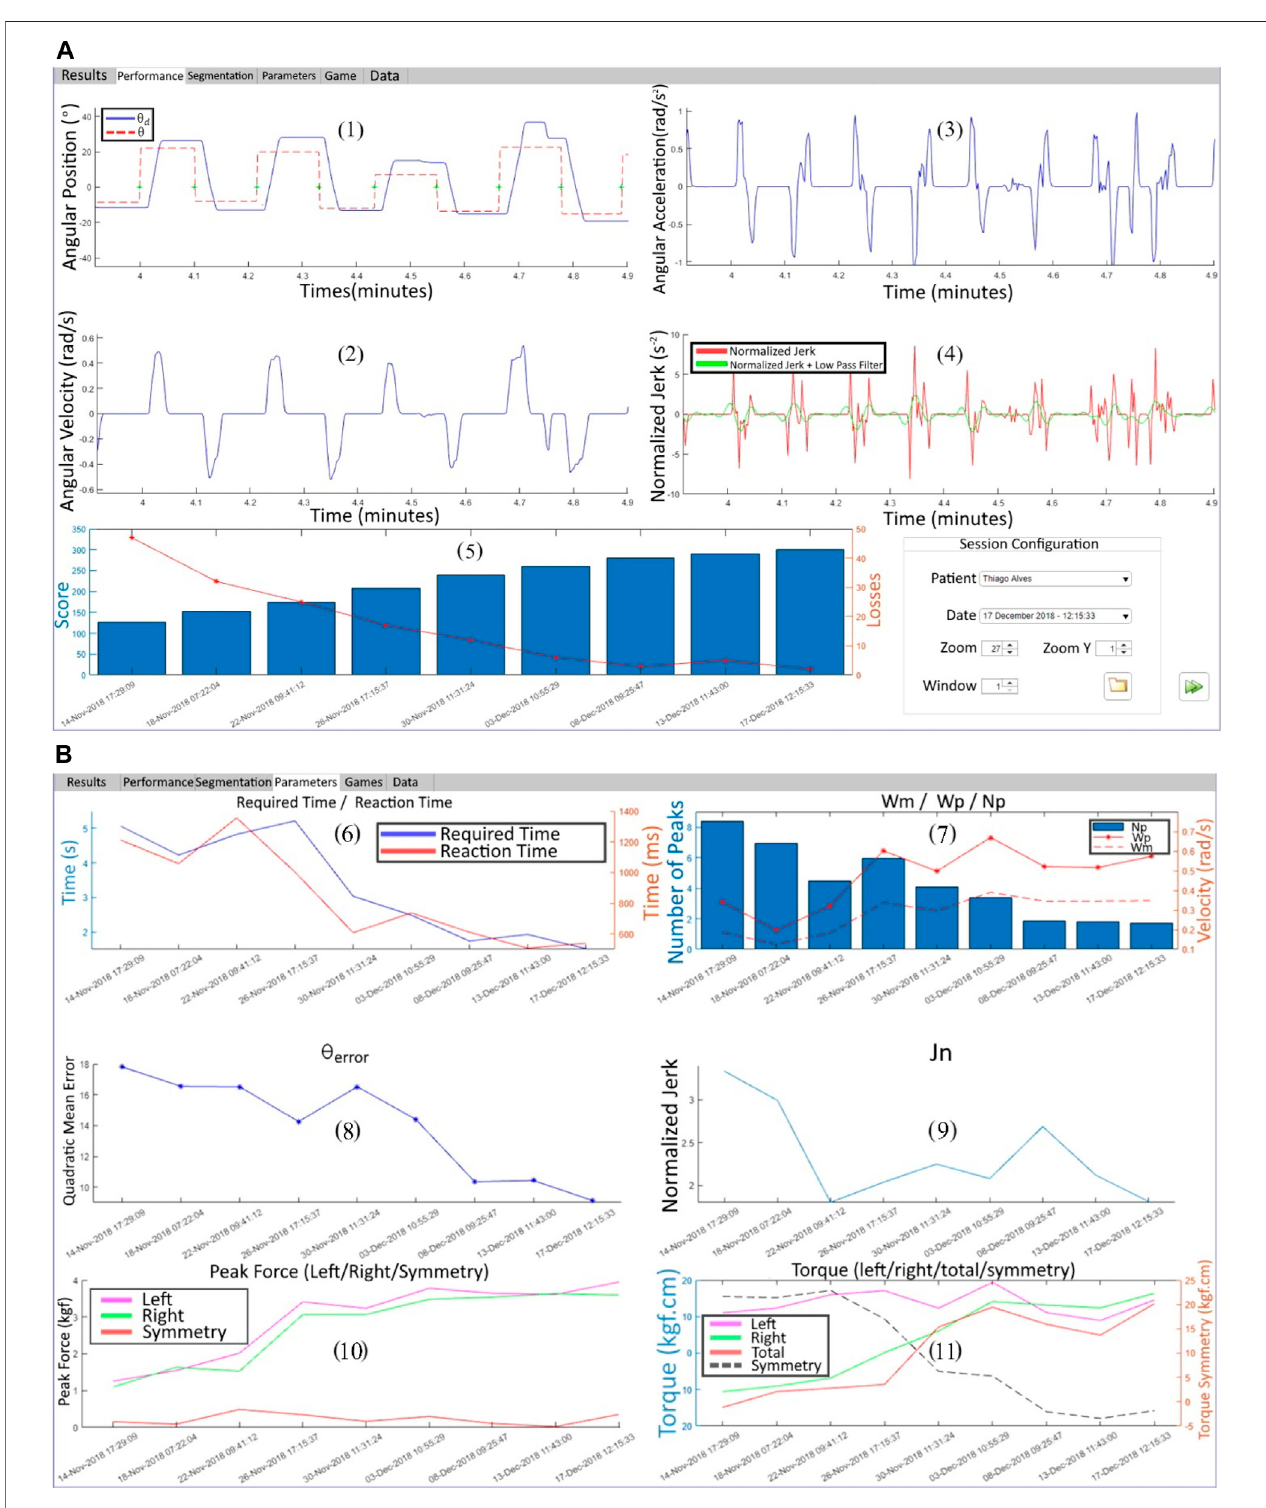
FIGURE 10 | BiEval software: (A) fi rst tab with (1) θ and θ d , (2) ω , (3) α , (4) J n and (5) score evolution in each rehabilitation session, (B) performance parameters evolution.